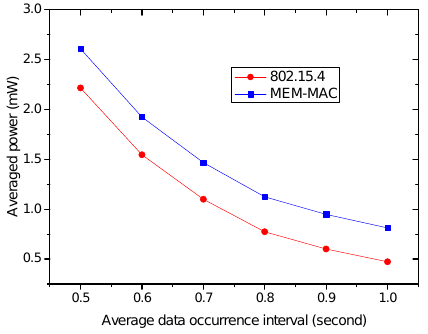
Figure 13. The node energy consumptions when traffic is busy.